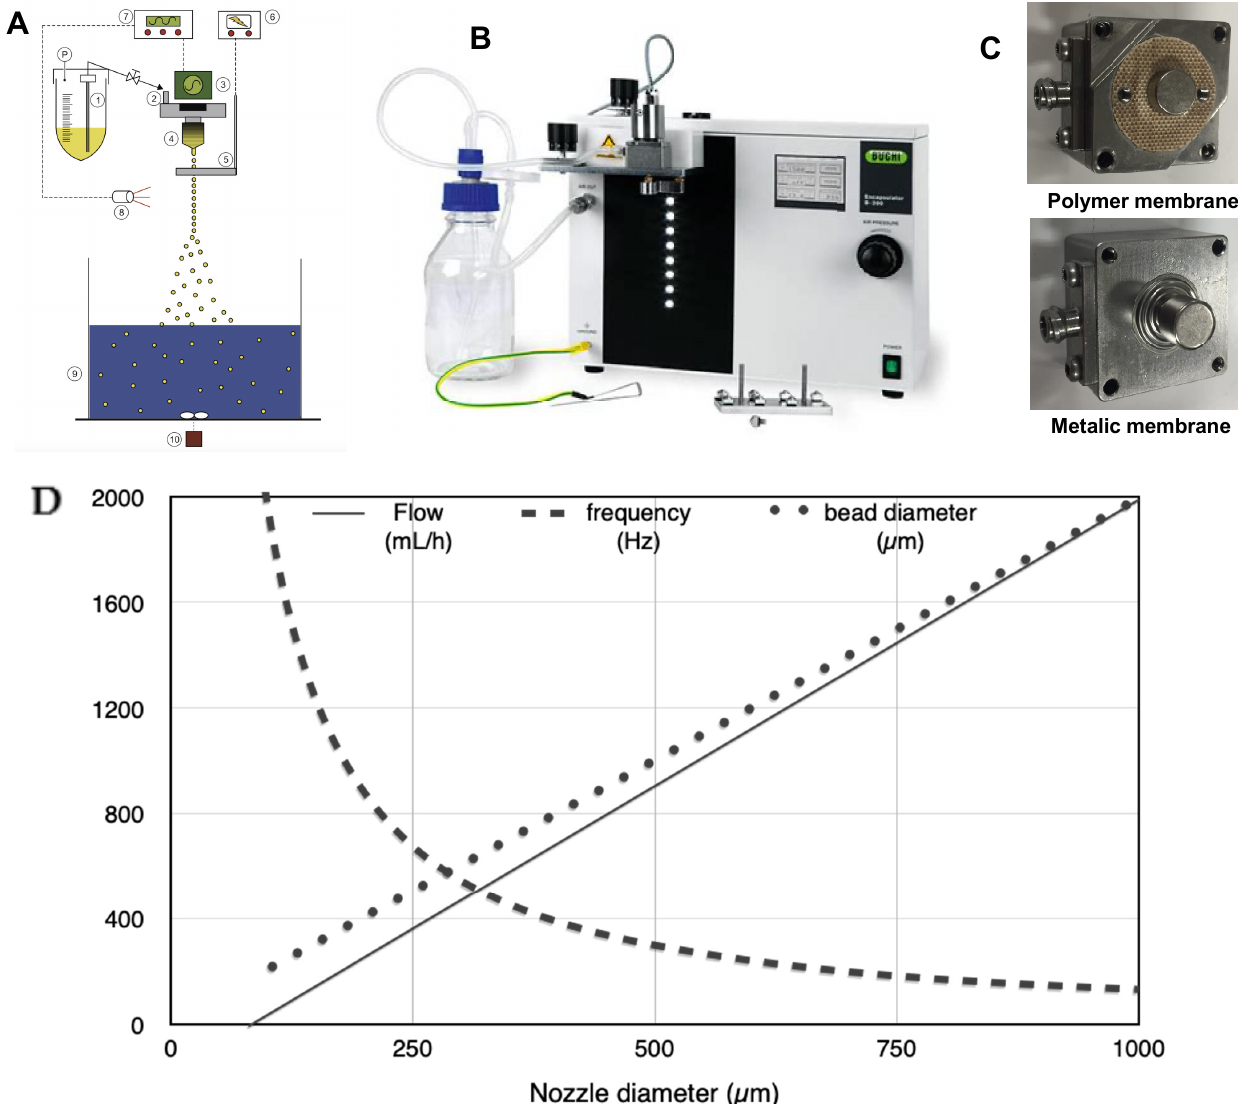
Figure 1. Buchi B-390 encapsulator. ( A ) Scheme of B-390 BUCHI encapsulator: ( B ) Equipment. ( C ) Details of the membranes ( D ) The optimal conditions for jet breakage according to the Buchi Encapsulator manual [15]. The feeding vessel was filled with the alginate solution. The frequency and ampli- tude were set following supplier recommendations corresponding to the selected